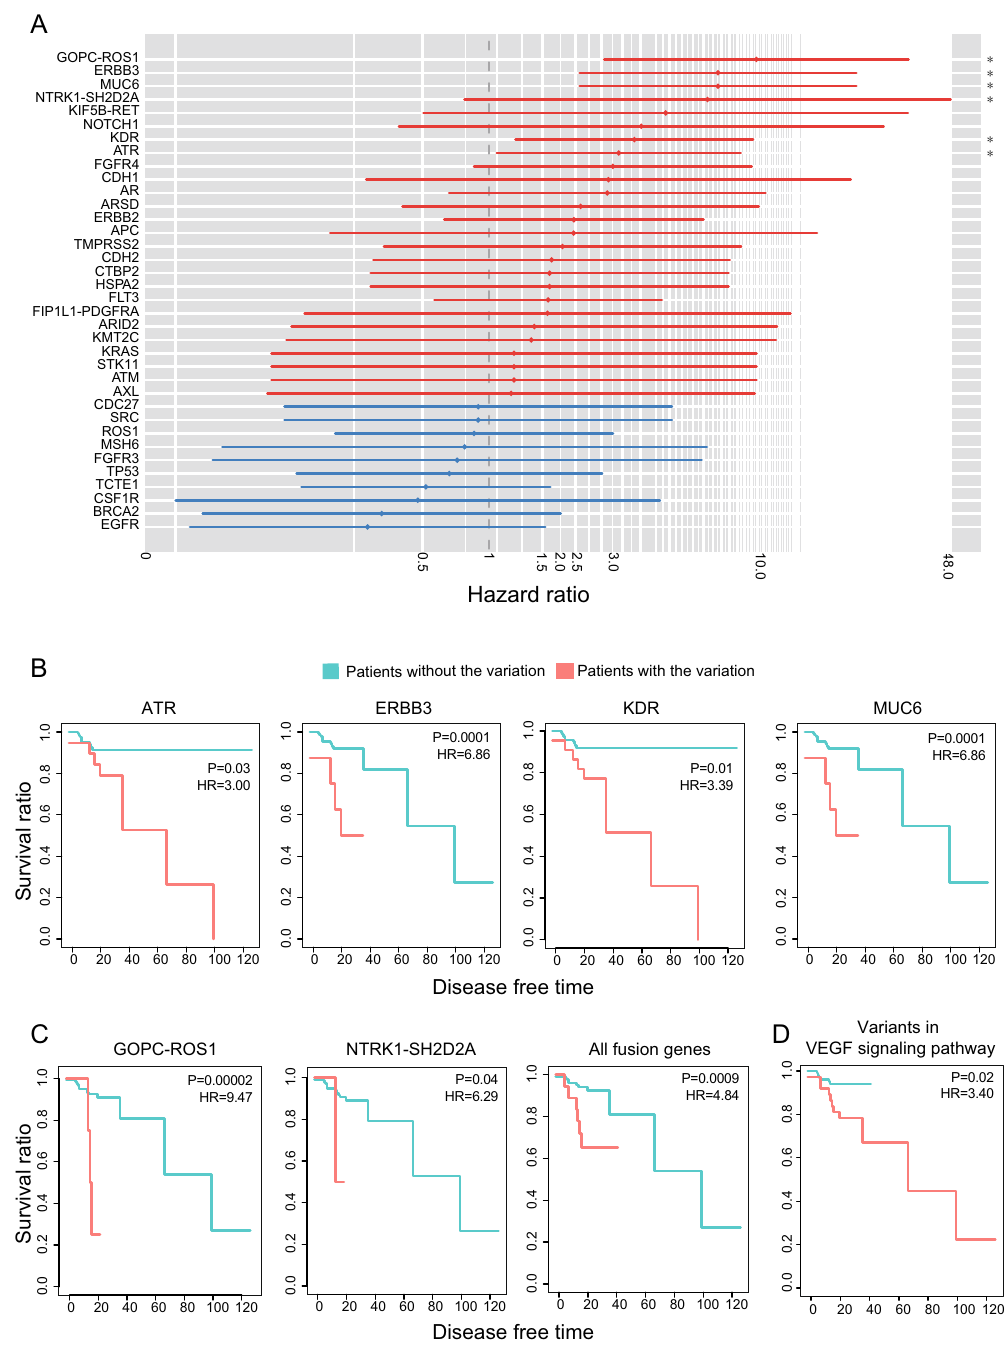
Figure 3. Prognostic signatures for the tumor recurrence. ( A ) The hazard ratio and significance of recurrence- free survival (RFS) tests for gene mutations and fusions in our NSCLC cohort. Only the genes whose frequency was over two were subjected to the RFS test, as it was calculated on a sufficient sample scale. The genes colored red indicate that patients with the gene variant showed a risk of tumor recurrence when compared to patients without the variant. Only the gene marked by an asterisk on the right side showed statistical significance in the RFS test. ( B ) Kaplan–Meier curves of the RFS tests for 4 gene mutations showing a significant hazard ratio. ( C ) Kaplan–Meier curves of the RFS tests for 2 fusion genes showing a significant hazard ratio. All fusion events, including the above two fusion genes, were also assessed by RFS tests. ( D) RFS tests for the gene set of the VEGF signaling pathway. We combined the status of the variants when they were enriched in a specific cancer-related pathway together when their frequency was more than two. Only the VEGF signaling pathway showed statistical significance in the RFS test among the cancer-related pathways. KDR, KRAS, SRC, and SH2D2A were included in the VEGF signaling pathway with variants in our